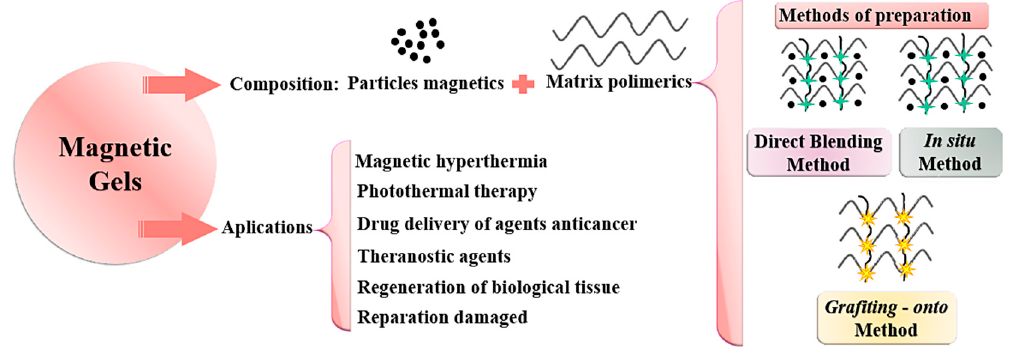
Figure 3. Schematic representation of the applications of magnetic gels and methods of preparation.